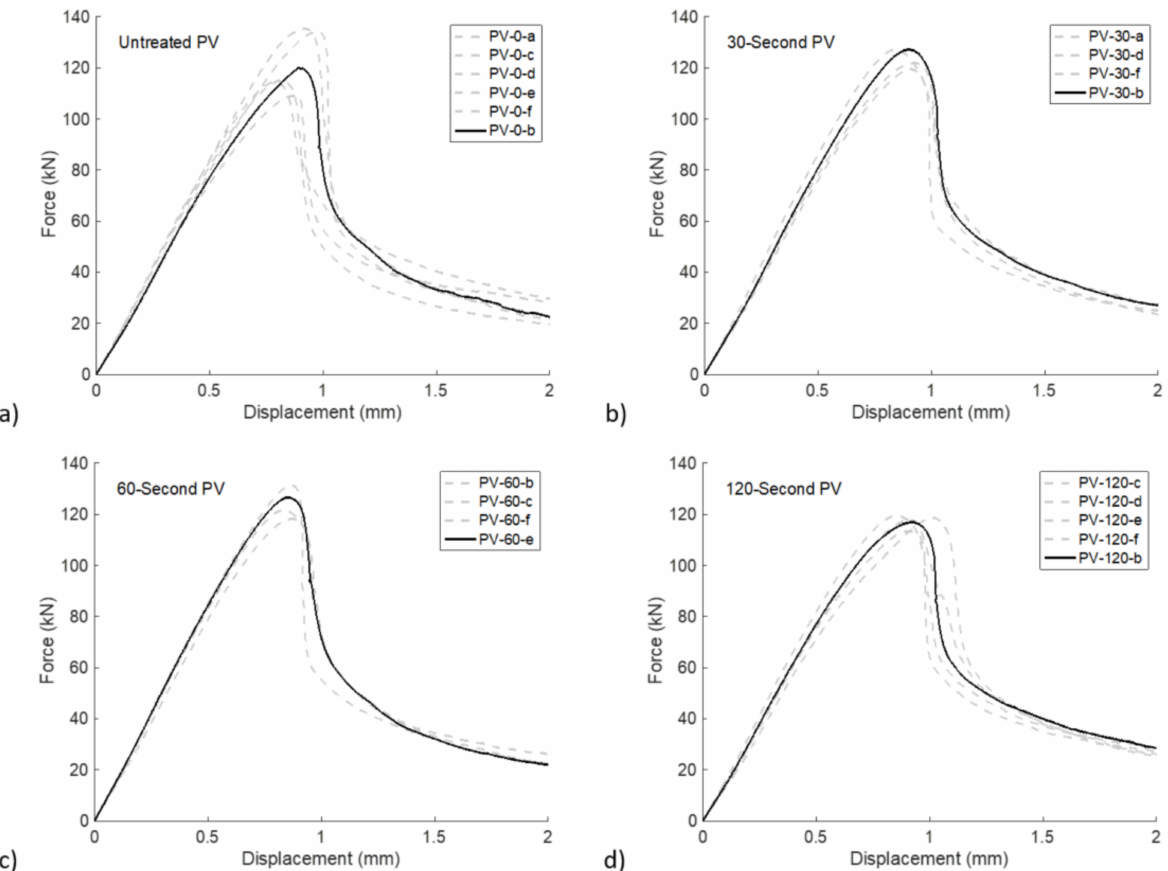
Figure A2. Force-displacement curves for all PV specimens tested in compression at ( a ) 0 s of treatment time, ( b ) 30 s of treatment time, ( c ) 60 s of treatment time, and ( d ) 120 s of treatment time.